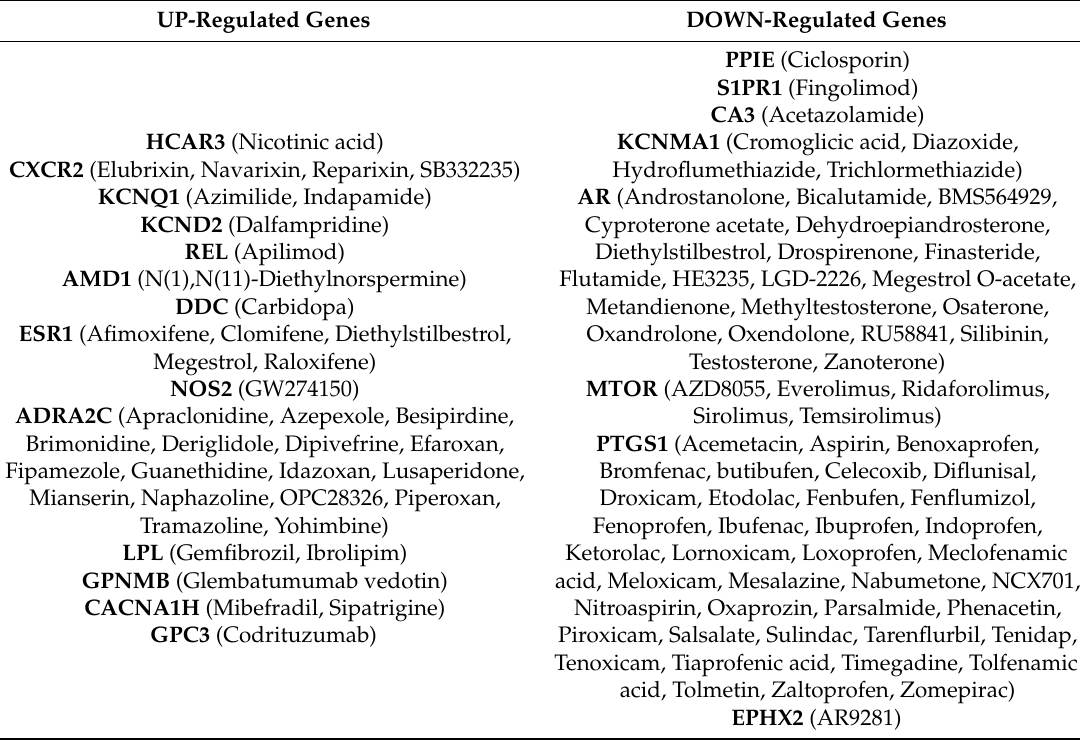
Table 4. List of known drug target proteins, together with correspondent compounds, that were up- or down-regulated in NE-like vs. AdenoPCa